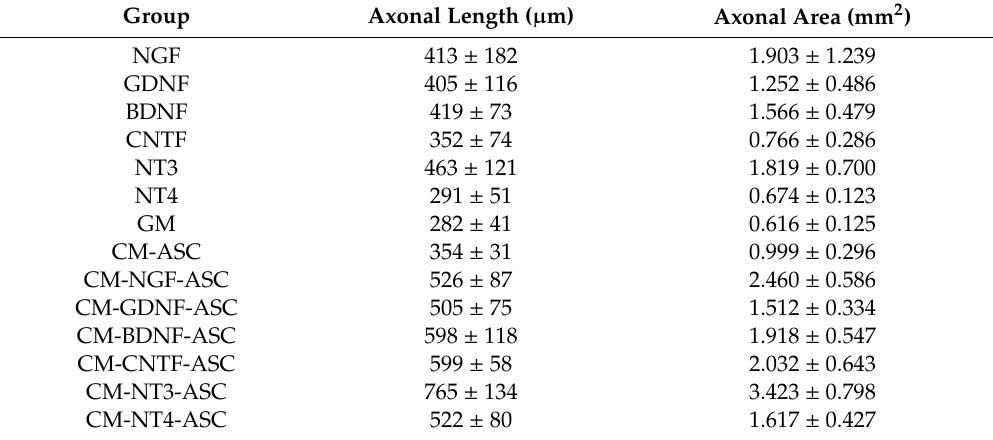
Figure 2. Distinct effects of individual NTF on axonal outgrowth. ( A ) Microphotographs of dorsal root ganglion (DRG) explants treated with NTF or growth medium alone (GM), ( B ) Quantitative measurements of axonal length ( μ m), and ( C ) Measurements of axonal area ( μ m 2 ). The scale bar represents 500 μ m. The bars represent mean ± SD of n = 12. Significant differences are indicated as * p < 0.05, ** p < 0.01 and *** p < 0.001. Table 1. Quantitative measurements of the axonal outgrowth resulting from DRG explants treated with differential stimuli. Data expressed in mean ± SD of n = 12.